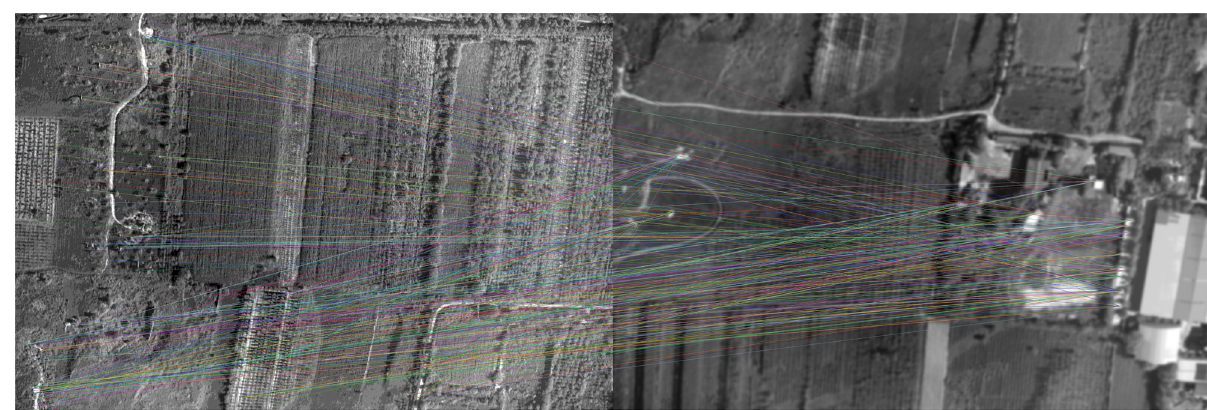
Fig 17. Matching results of aerial images with different sharpness by BRIEF algorithm.